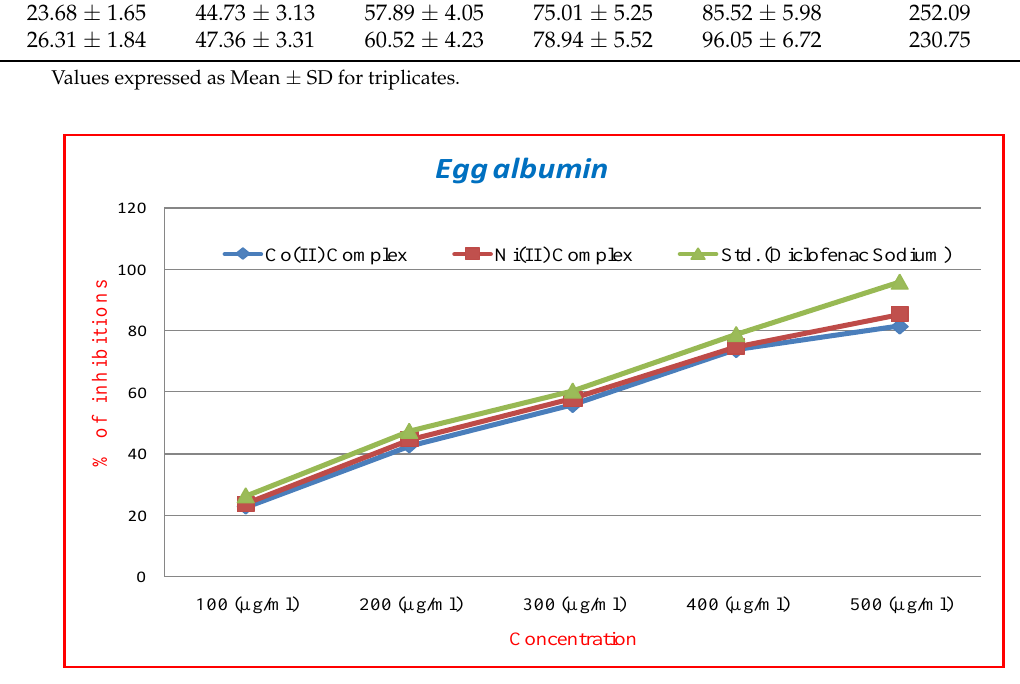
Figure 9. In-vitro anti-inflammatory (egg albumin) activity of Co(II) and Ni(II) complexes.